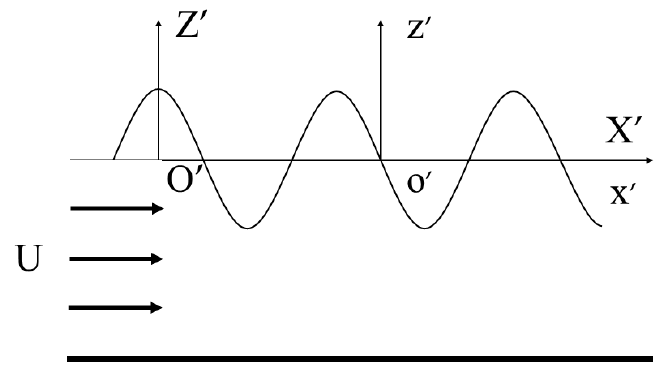
Figure 3. Coupling effect of waves and currents.